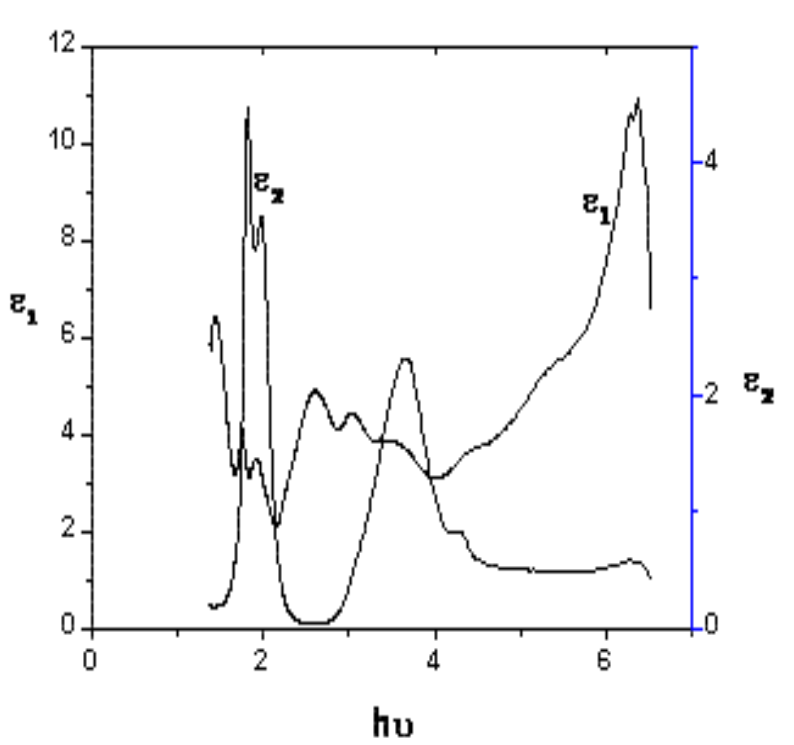
Figure 5. The real and imaginary parts of the dielectric constant of ZnTTBPc as a function of its photon